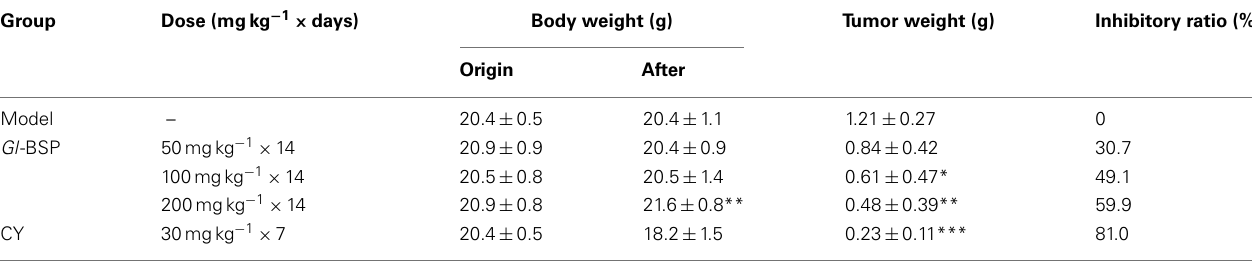
Table 1 |Antitumor effect of Gl -BSP on Sarcoma 180 in BALB/c mice ( n = 10, ¯ x ± s).